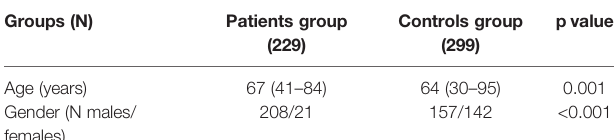
TABLE 2 | Demographic characteristics of the healthy controls ’ and NSCLC patients ’